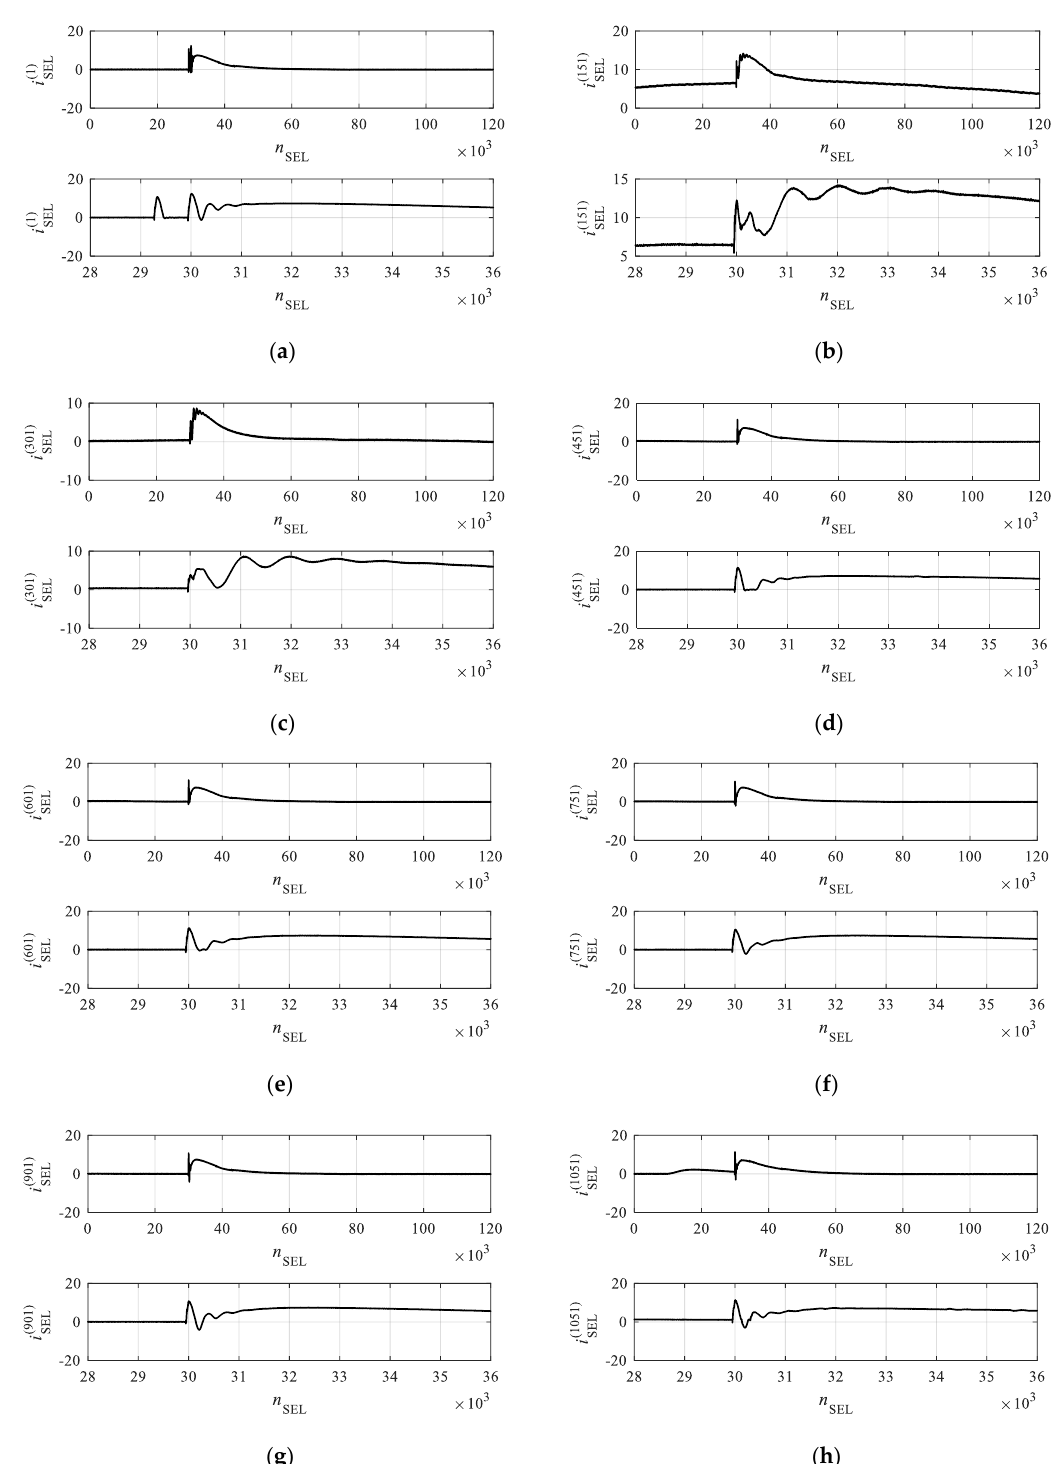
l i for selected examples l belonging to categories 0 – 7. ( l ) Figure 18. Current vector ( ) Figure 18. Current vector i for selected examples l belonging to categories 0–7. l = 1: No EA ( a ), l = 151: vacuum cleaner S EL SEL ( b ), l = 301: slow juicer ( c ), l = 451: lamp with bulb “Osram“ ( d ), l = 601: lamp with bulb “Philips“ ( e ), l = 751: lamp with bulb “Omega” ( f ), l = 901: wall lamp with four bulbs “Lexman” ( g ), l = 1051: laptop ( h